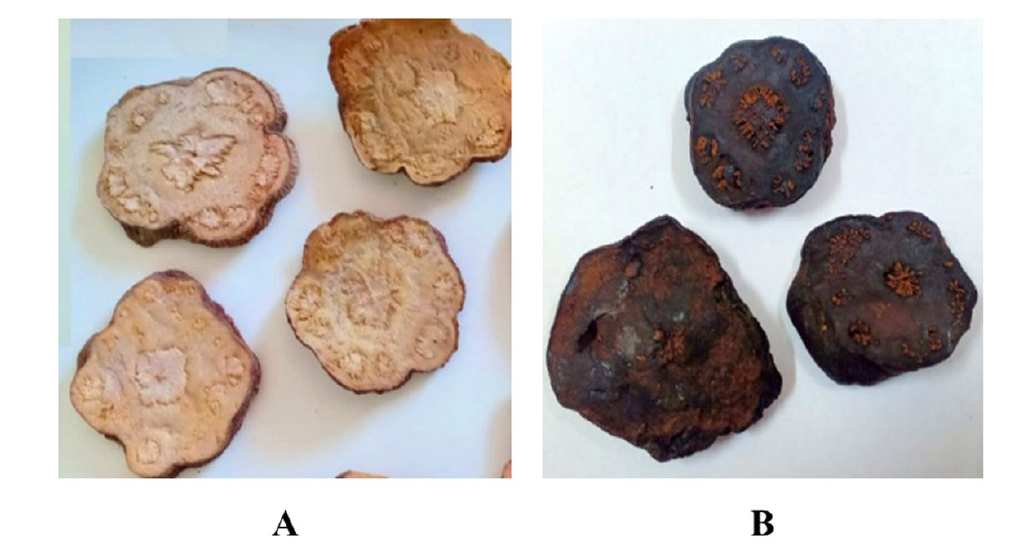
FIGURE 2 - FMT roots before (A) and after (B)